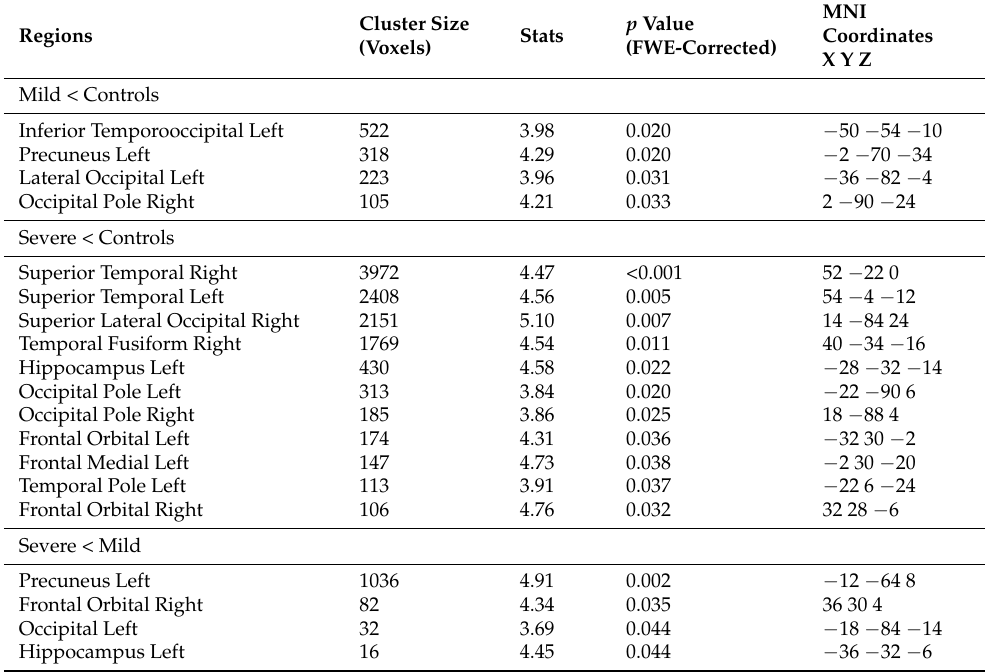
Table A1. Structural gray matter differences.